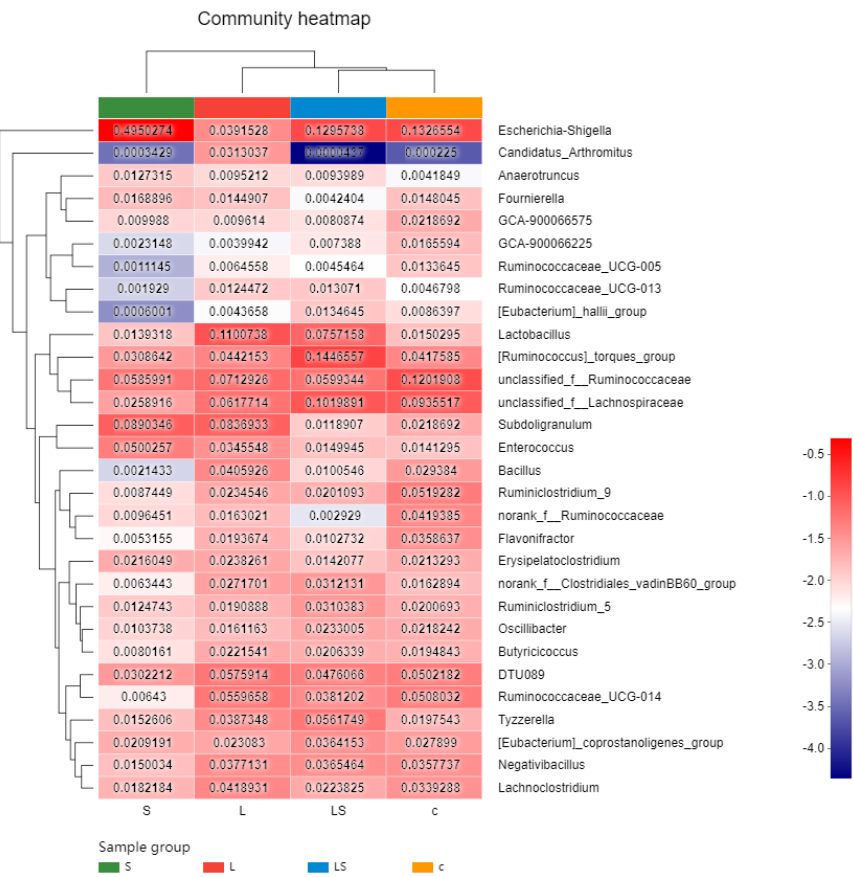
Figure 5. Heat map analysis of relative abundance of cecum intestinal flora of chickens after L. reuteri S5 intervention. The variation of the abundance of different species in the sample is displayed through the color gradient of the color block, and the numbers in the figure represent the relative abundance value of the species.